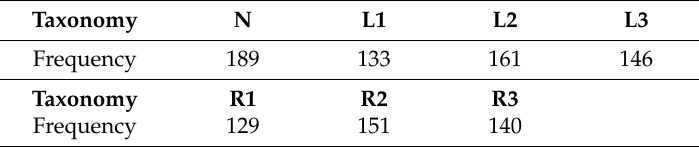
Table 4. Frequencies in dataset